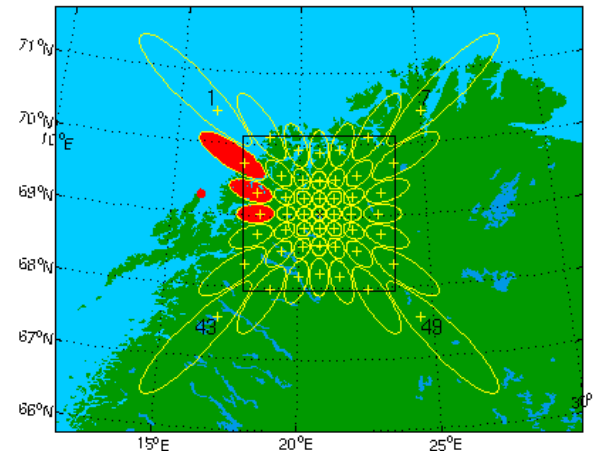
Fig. 2. The beam projection for the 49 beams of IRIS at 90km (Map: S. Marple, Lancaster University). None of the riometer beams overlap with the ALOMAR Weber Na lidar (marked as a red dot), but beam 8, 15 and 22 (coloured red) might be representative for the absorption above